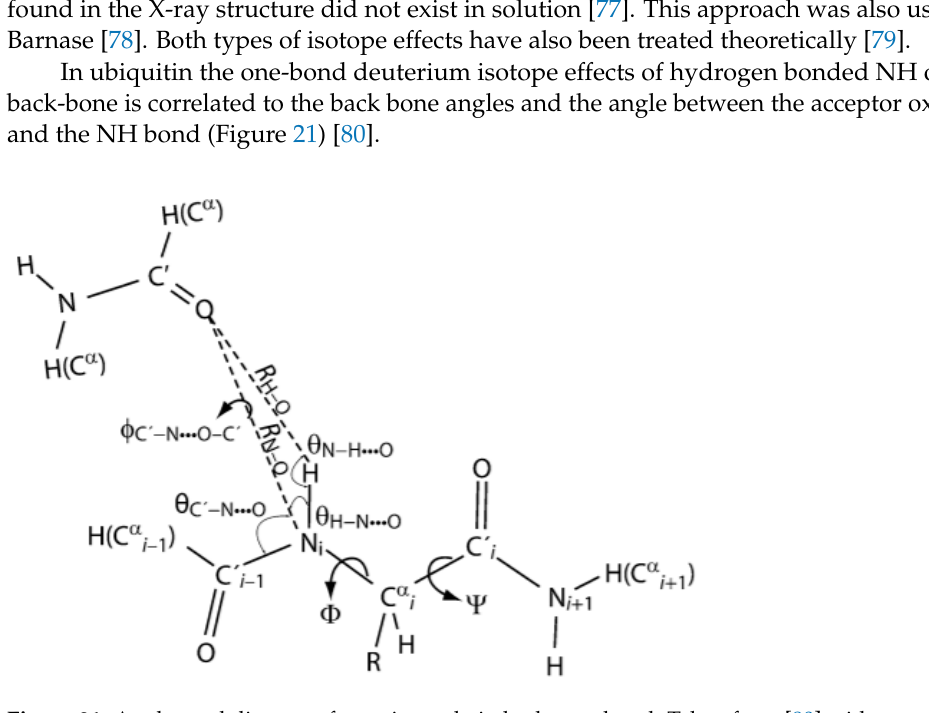
Figure 21. Angles and distances for an inter ‐ chain hydrogen bond. Taken from [80] with permis ‐ sion from Springer.